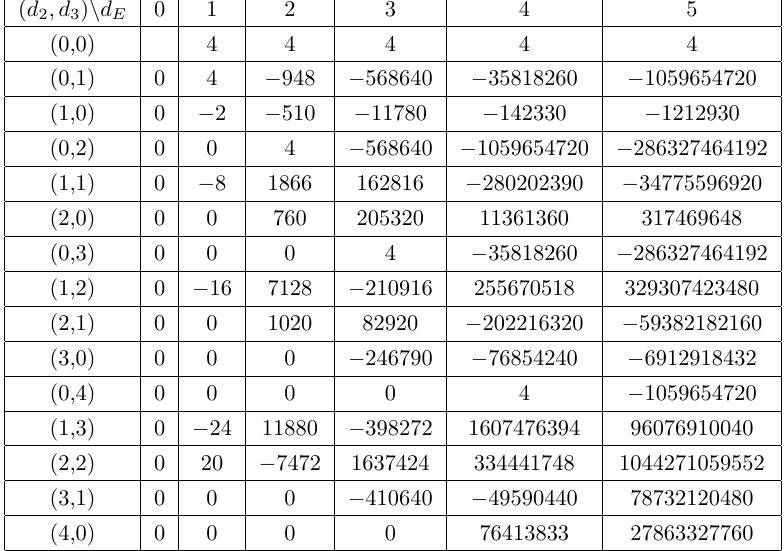
for the genus ( g ) = (0 , 0) L , g R ( d E ,d 2 ,d 3 )